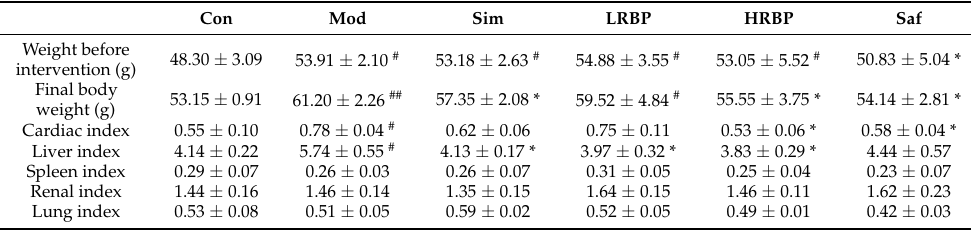
Table 1. Body weight and organ indices of the mice in each experimental group. Con Mod Sim LRBP HRBP Saf Weight before ± 3.09 53.91 ± 2.10 # 53.18 ± 2.63 # 54.88 ± 3.55 # intervention (g) 48.30 Final body ± 0.91 weight (g) 53.15